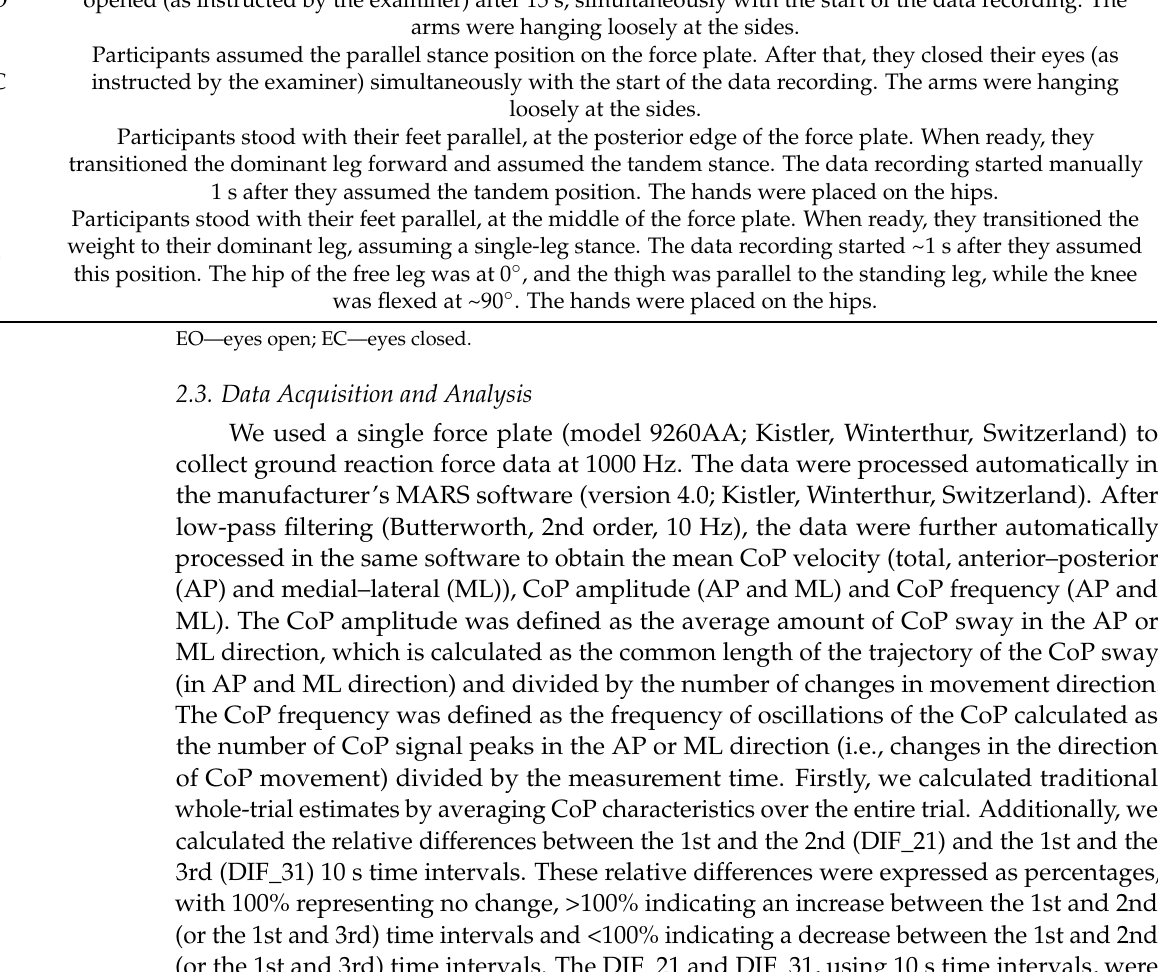
Table 2. An overview of postural tasks performed in the study. Task Descriptions of the Tasks and the Transition to the Task Positions Participants assumed the parallel stance position on the force plate and closed their eyes. The eyes were Parallel EO opened (as instructed by the examiner) after 15 s, simultaneously with the start of the data recording. The arms were hanging loosely at the sides. Participants assumed the parallel stance position on the force plate. After that, they closed their eyes (as Parallel EC instructed by the examiner) simultaneously with the start of the data recording. The arms were hanging loosely at the sides. Participants stood with their feet parallel, at the posterior edge of the force plate. When ready, they Tandem transitioned the dominant leg forward and assumed the tandem stance. The data recording started manually 1 s after they assumed the tandem position. The hands were placed on the hips. Participants stood with their feet parallel, at the middle of the force plate. When ready, they transitioned the weight to their dominant leg, assuming a single-leg stance. The data recording started ~1 s after they assumed Single-leg this position. The hip of the free leg was at 0 ◦ , and the thigh was parallel to the standing leg, while the knee was flexed at ~90 ◦ . The hands were placed on the